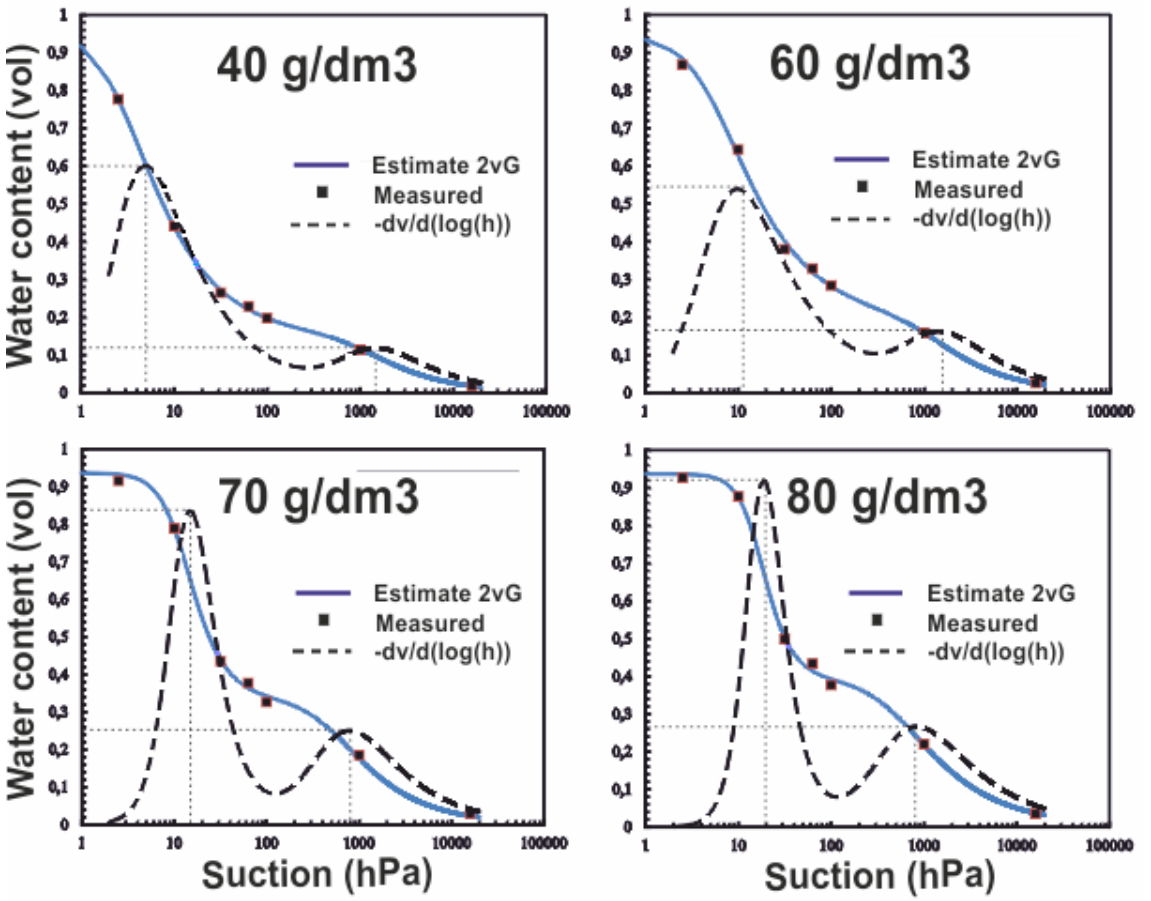
Figure 9. The fitted double van Genuchten models (solid blue curves) with measured experimental values (points) and the pore size distribution functions (-dv/d(log h); dashed black curves) for four different bulk densities. Two points of inflection in the WRC function, i.e . points where the curvature of the function changes its sign, indicate the presence of two distinctive pore size ranges in Sphagnum . The matric water suction corresponding to the modal pore sizes of the two ranges can be estimated from the positions of the maxima of the pore size distribution curve on the x-axis (dotted